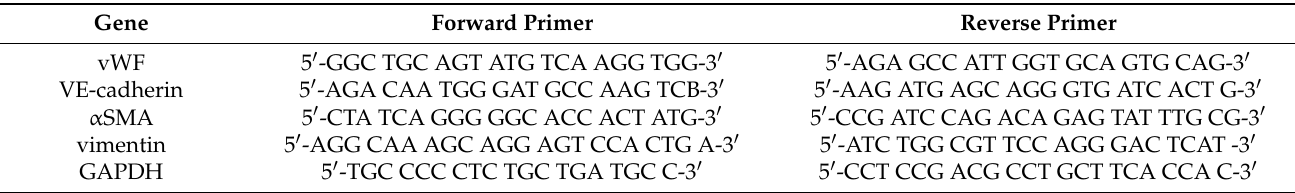
Table 1. The primer sequence for real-time